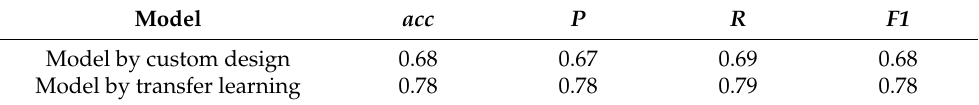
Table 7. Comparison of the two proposed models in terms of acc , P , R and F1 score.